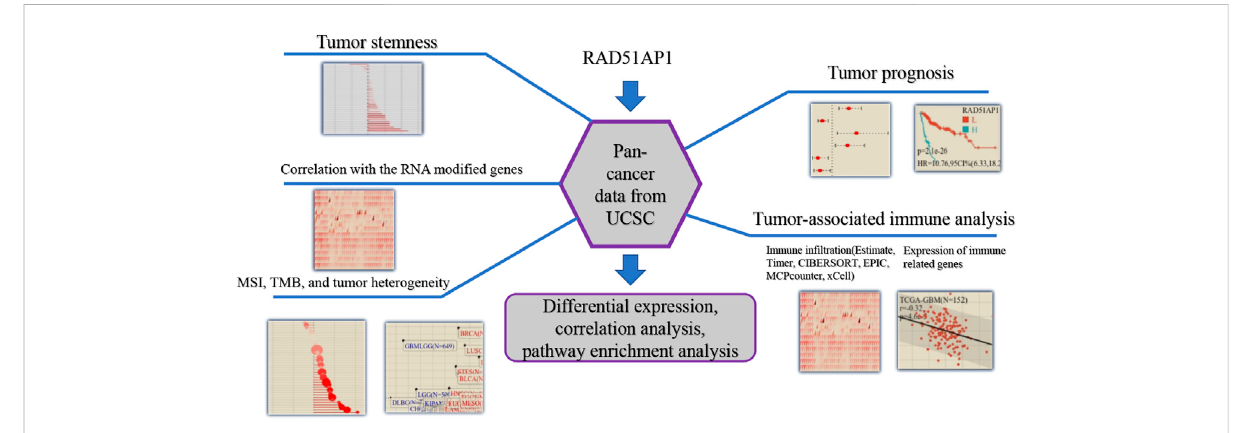
FIGURE 1 Flowchart of the principal bioinformatics analysis in this